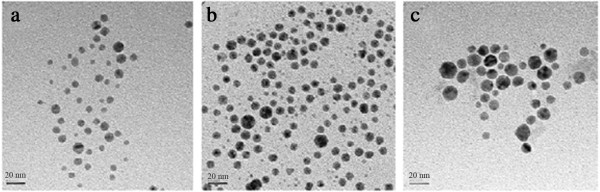
TEM images of gold nanoparticles. TEM images of gold nanoparticles prepared by γ-irradiation at various concentration of HAuCl4: (a) 2 × 10-4, (b) 1 × 10-3, and (c) 2 × 10-3 M [60].